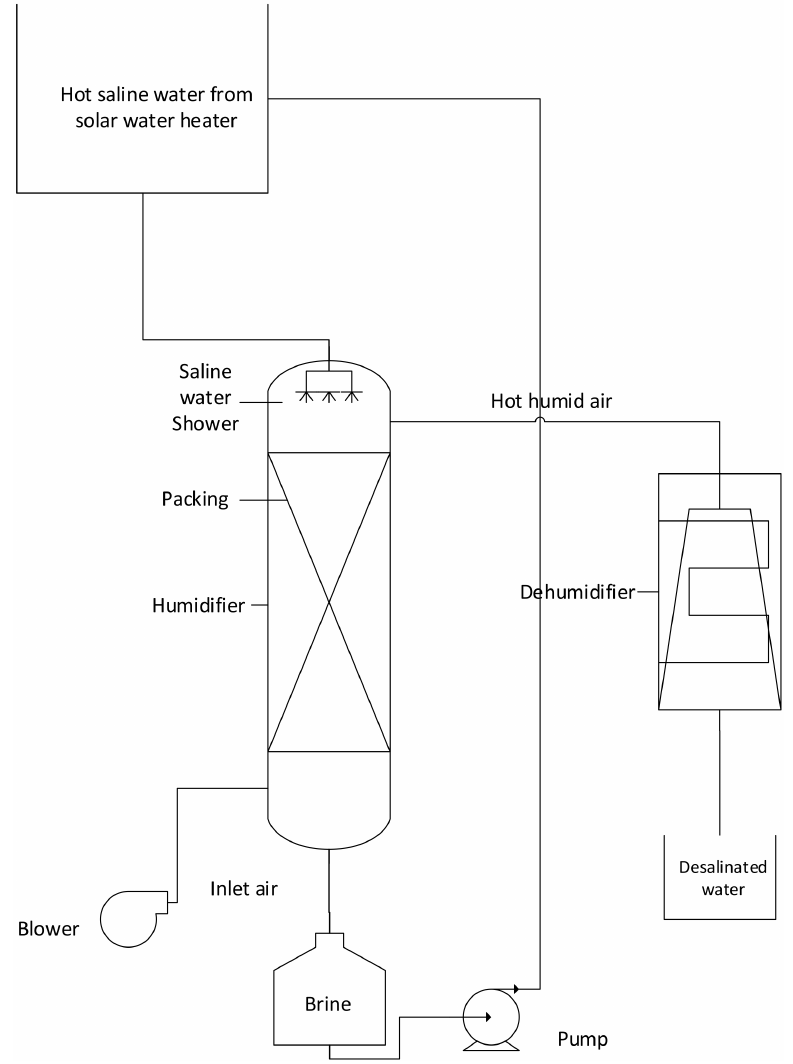
Figure 4. Schematic of HD experimental